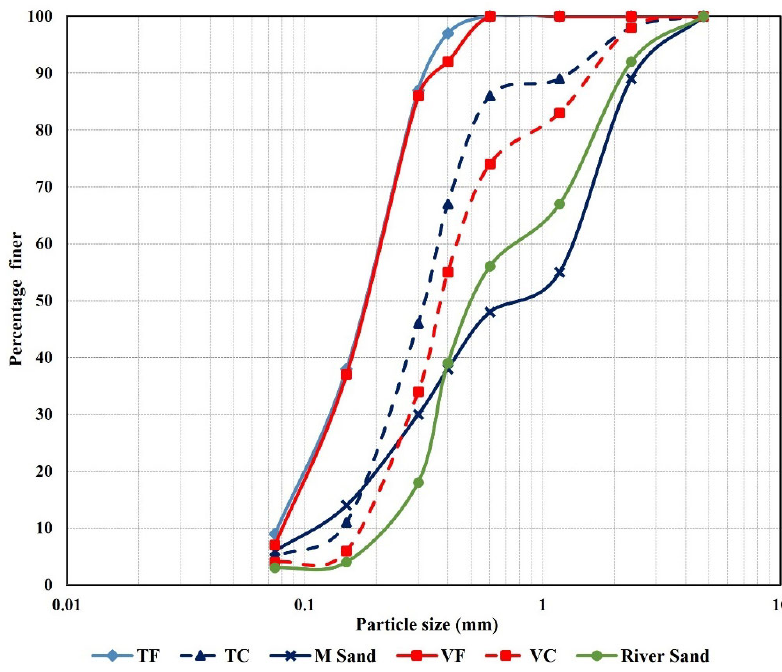
Figure 2. Particle size analysis. Table 1. Fineness modulus of sand samples and classification as per IS 383 ‐ 1970.